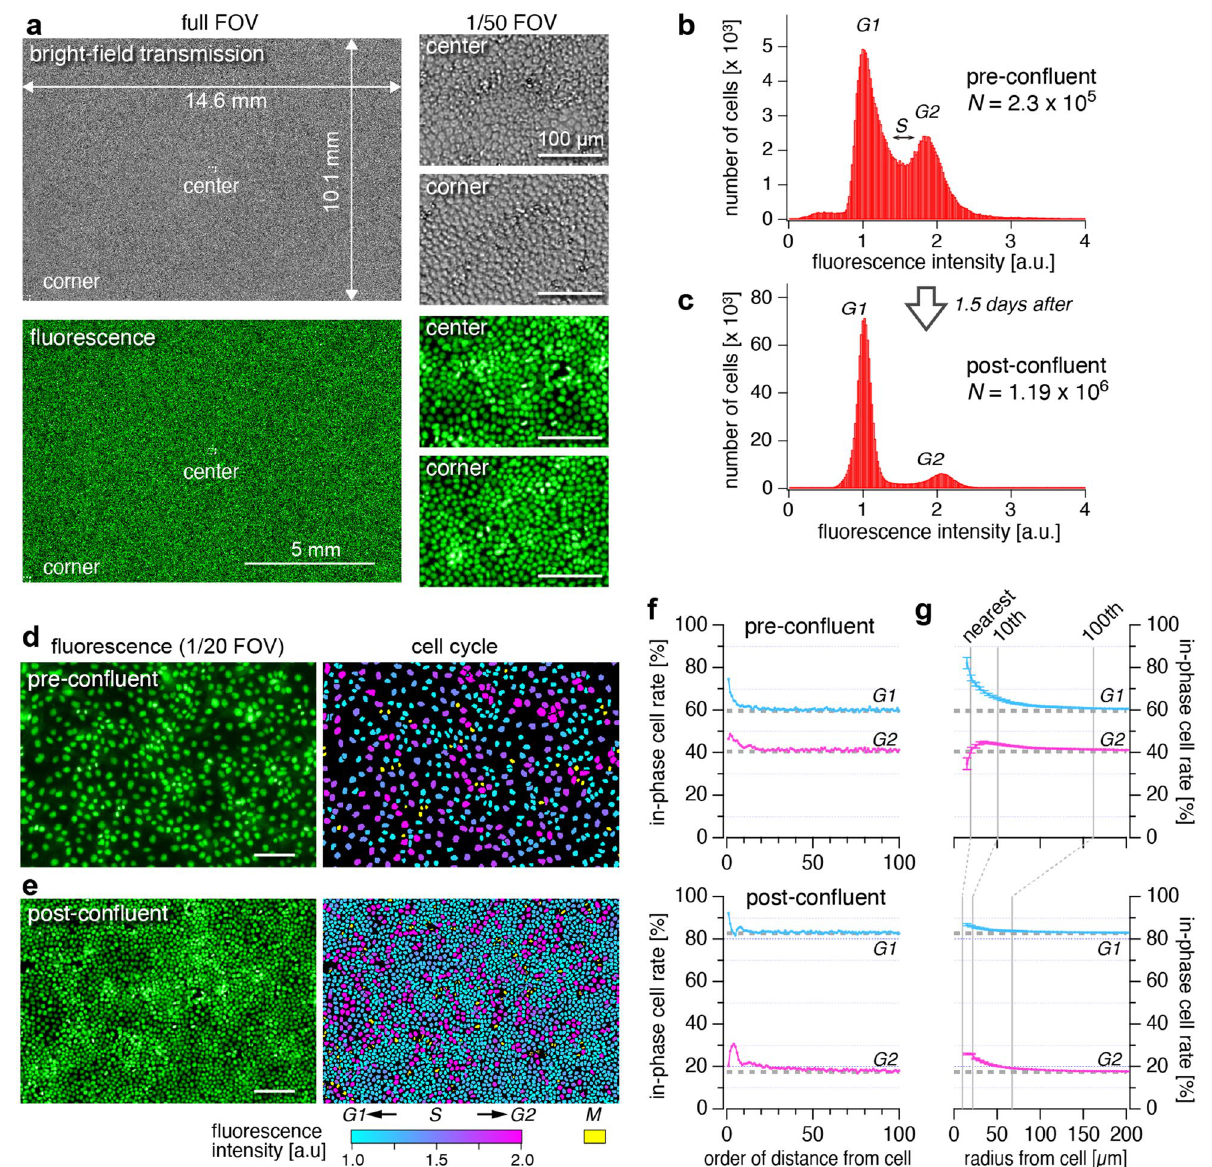
Figure 3. Single shot detection and analysis of more than one million cells. Imaging of the cultured MDCK cells that were fixed with paraformaldehyde and stained with NucleoSeeing was performed with an excitation LED wavelength of 470 nm. ( a ) Full FOV image and closeup images of the area covering 1/50 of the FOV region at the center and corner, obtained with the bright-field transmission (top three) and fluorescence (bottom three) modes. ( b , c ) Histograms of fluorescence intensity of cells with two different cell densities ( b : pre-confluent, c : post-confluent), which correspond to the populations of cells in the G1, S and G2 phases. The fluorescence intensity was normalized by the peak position for the G1 phase. ( d , e ) Closeup views of areas comprising 1/20 of the FOV region obtained at the pre-confluent condition ( d ) and the post-confluent condition ( e ). In the right panels, nuclei of interphase cells are painted with colors indicating fluorescence intensities of the cells, with each color corresponding to different phases of the cell cycle, i.e. , cyan and magenta represent the G1 and G2 phases, respectively. Nuclei of the M phase cells are painted with yellow. Scale bars: 100 µm. ( f , g ) Spatial analysis of the cells in the two phases. ( f ) In-phase cell rate of neighboring cells as a function of order of cell-cell distance ( G1 : cyan, G2 : magenta). ( g ) In-phase cell rate among the cells in the neighboring area was plotted as a function of the radius of the area ( G1 : cyan, G2 : magenta). The error bars represent standard errors. The dashed gray lines in f and g represent the expected values for random